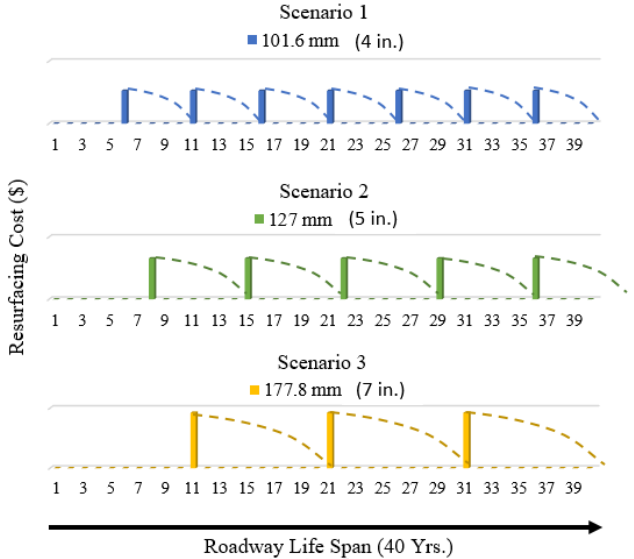
Figure 27. Cashflow streams for TWT over a 40-year life span of the roadway using both ordinary concrete and rubberized concrete for different scenarios.